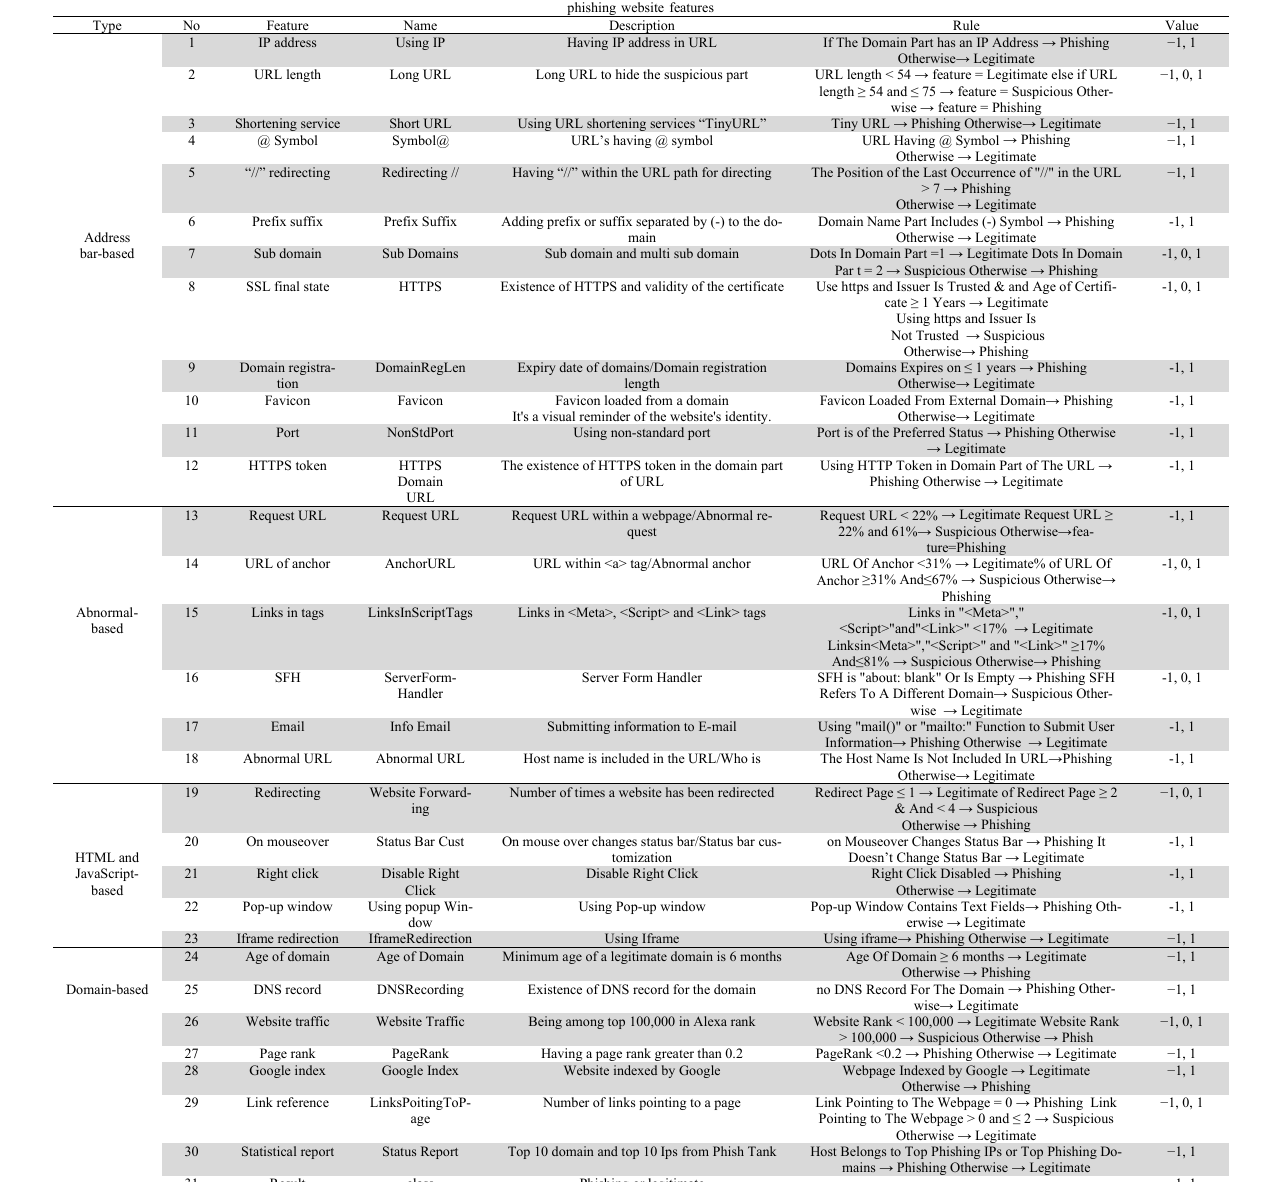
List of phishing website features.